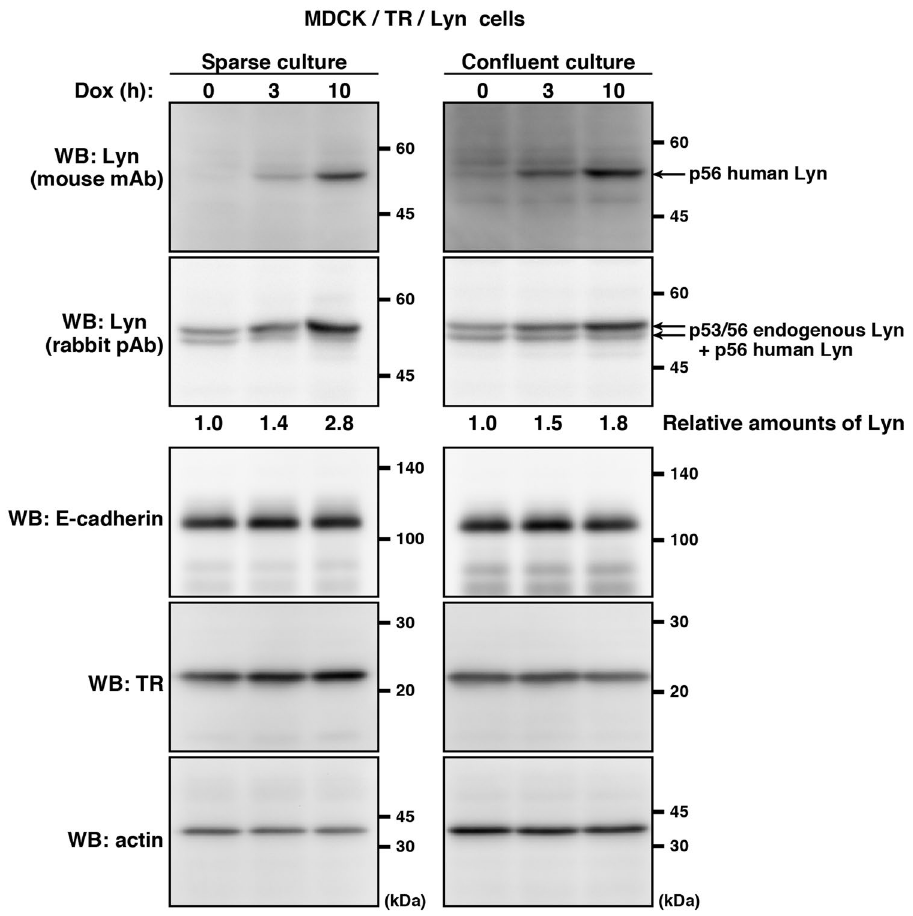
Figure 1. Establishment of an MDCK cell line expressing inducible Lyn. MDCK/TR/Lyn cells were grown in sparse and confluent cultures, which generates non-polarized cells and polarized cells, respectively. The cells were subsequently treated with 1 μ g/ml doxycycline (Dox) for the indicated times. Whole cell lysates were subjected to Western blot analysis using the indicated antibodies. TR, tetracycline repressor. Molecular size markers are shown in kDa. The amount of p53/p56 Lyn in Dox-treated cells is expressed as the value relative to that in cells without Dox treatment after normalization with actin levels. For better clarity and conciseness of the presentation, cropped blots are shown. The full-length blots are presented in Supplementary Fig.